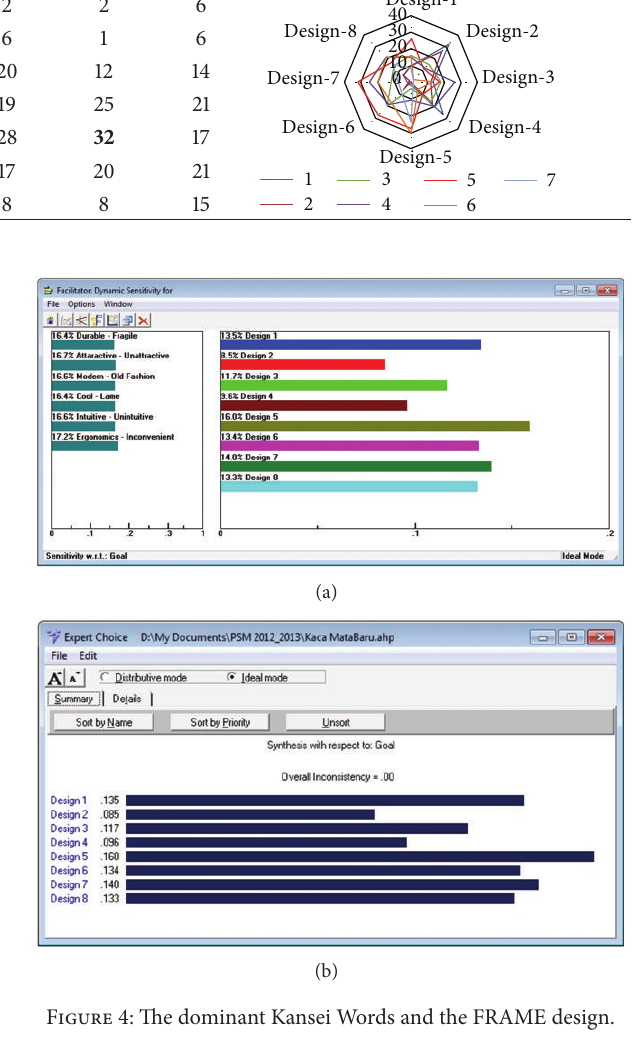
Figure 4: The dominant Kansei Words and the FRAME